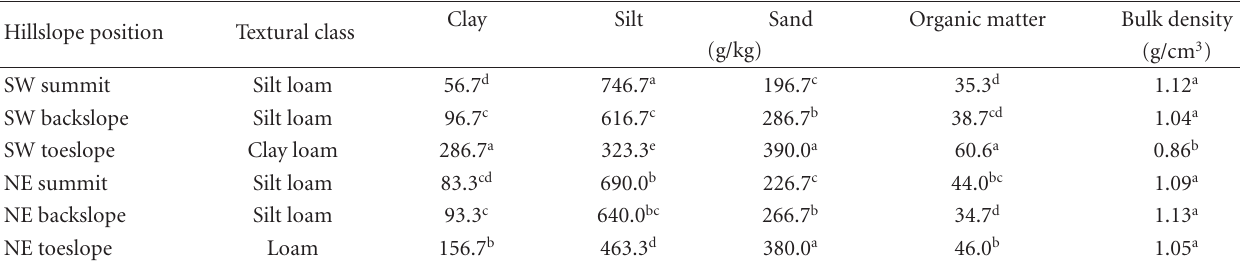
Table 1: Average measured soil physical properties for the shallow seedling recruitment zone of the hillslope positions.